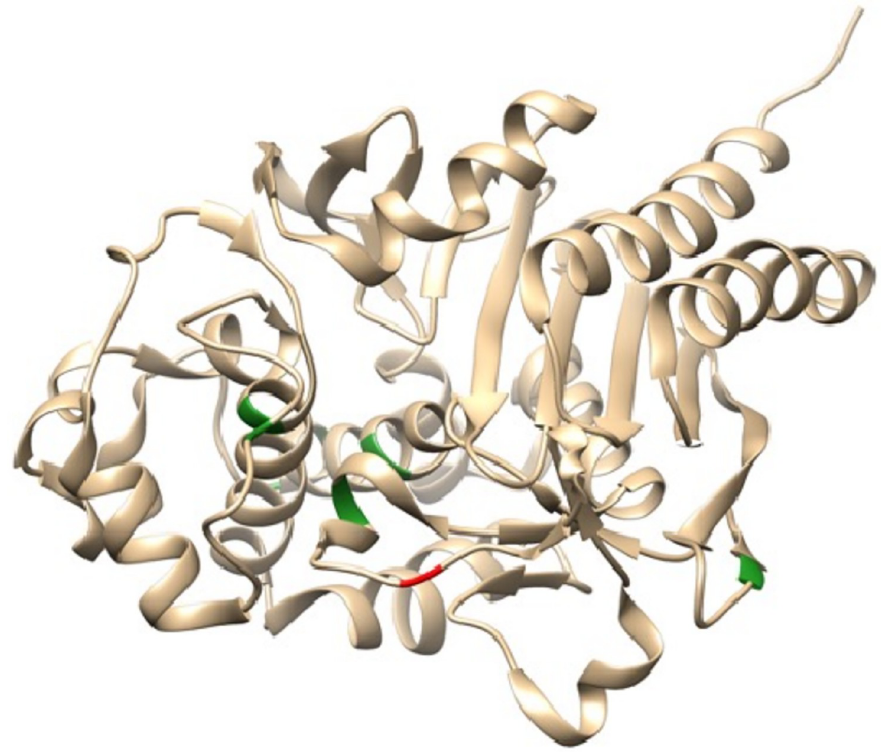
Fig 3. PDC structure (PDB ID 4GZB) showing the region where the deletion (red) and substitutions listed in Table 1 (green) where found.